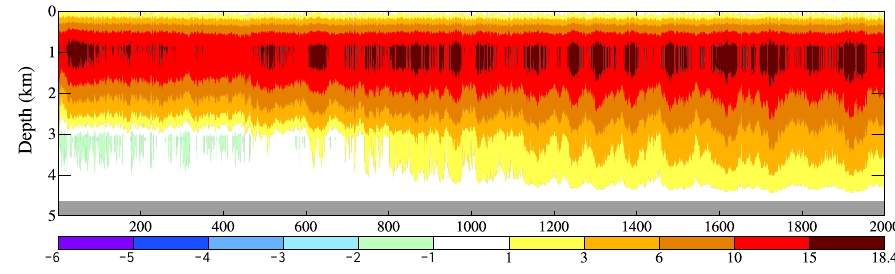
Figure 3. Annual mean AMOC (Sv) at 28 ◦ N in the model control run.